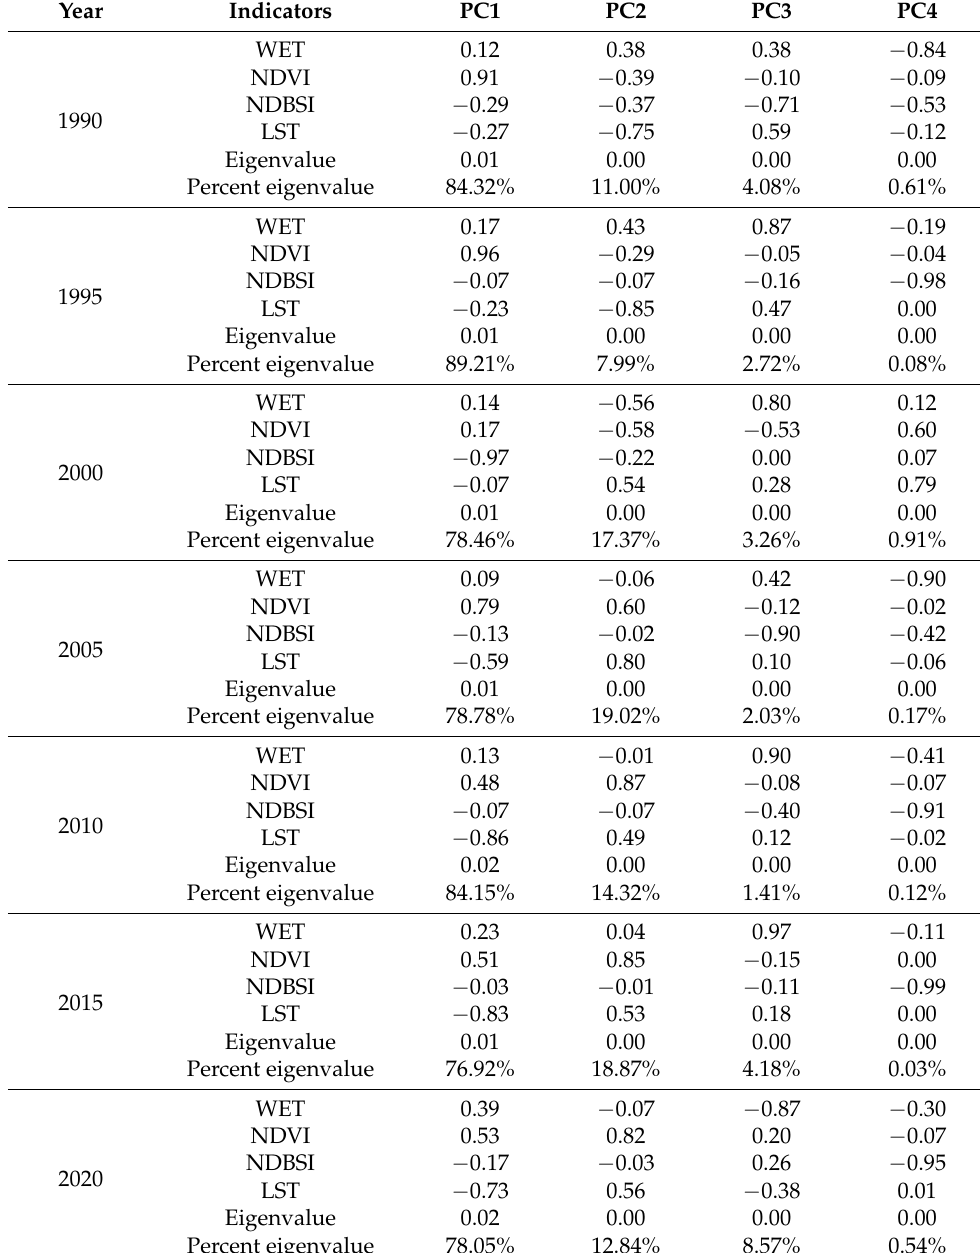
Table 1. PCA Results of RSEI from 1990 to